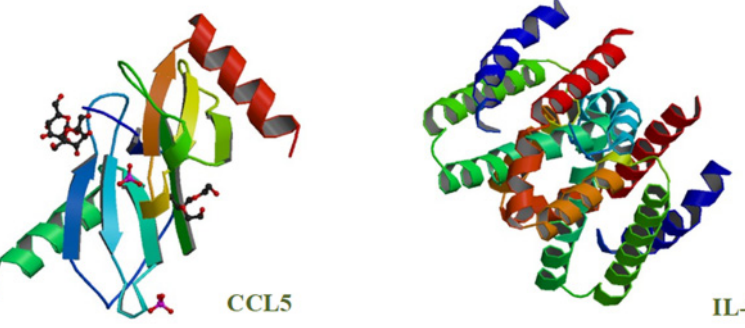
Figure 1. Structure of selected cytokines: chemokines CCL5 and interleukins IL-10 (source: [1]). Cytokines play important roles during embryonic development, and they can both trigger and inhibit inflammatory responses. Cytokines participate in disease pathogenesis; they are responsible for communication between cells, changes in cognitive functions, senescence processes, responses to infectious and inflammatory factors, specific responses to antigens and infections; and they participate in the differentiation of stem cells. Cytokines are produced mainly by immune system cells (monocytes, macrophages and